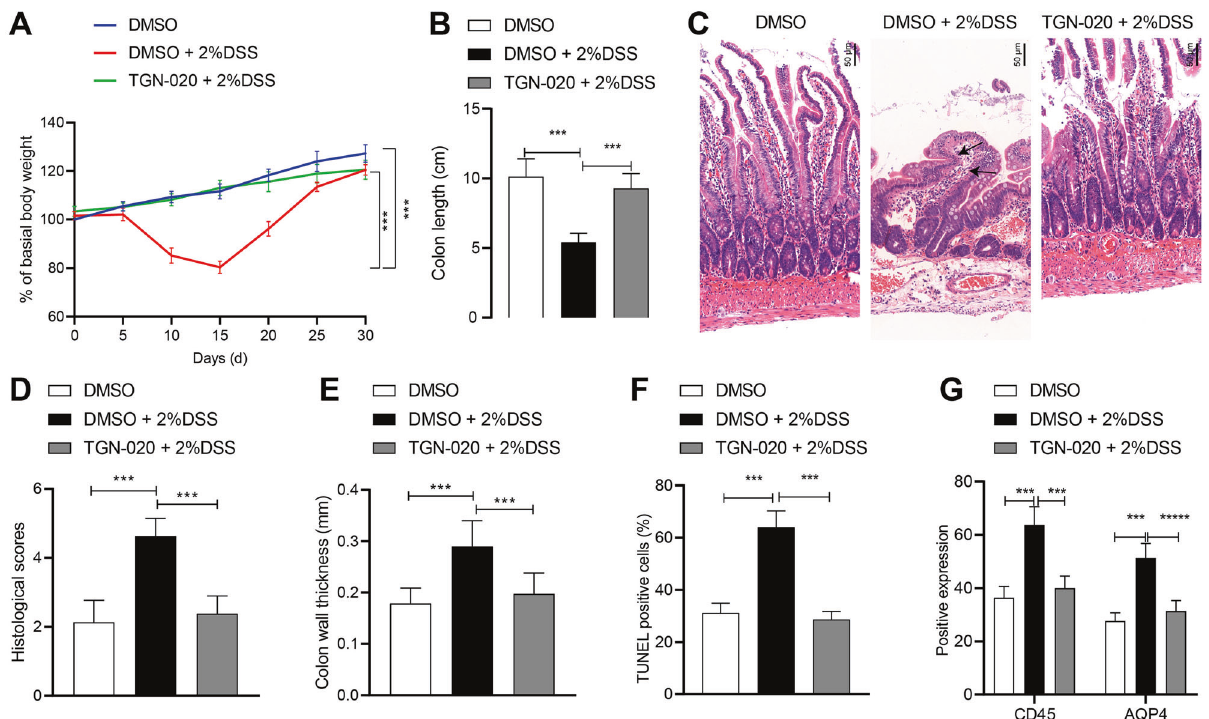
Fig. 6 AQP4 inhibitor TGN-020 alleviates experimental colitis in mice. A The statistic analysis for the changes in mouse weight after treatment with TGN-020. B The colon length of the mice after treatment with TGN-020. C HE staining to observe the pathological changes of colon tissues in TGN-020 treated mice (200×). D Statistical scoring results. E Graphical quanti fi cation of the colon wall thickness. F TUNEL staining analysis the apoptosis of colon epithelial cells in TGN-020 treated mice. G Immunohistochemistry of the expression of CD45 and AQP4. * p < 0.05. The measurement data were expressed as mean ± standard deviation. Data between two groups were compared by the unpaired student ’ s t test, and data among multiple groups were compared by one-way ANOVA, followed by Tukey ’ s post hoc tests. The experiment was conducted three times independently. n = 8; *** p <